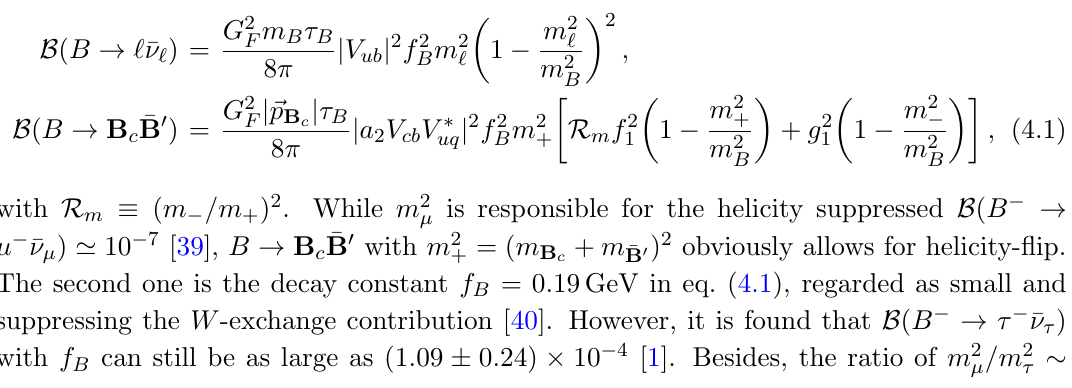
( (cid:22) B 0 (cid:3) + (cid:22) p ) should be at the level of 10 (cid:0) 5 . With N c = 2 : c B !